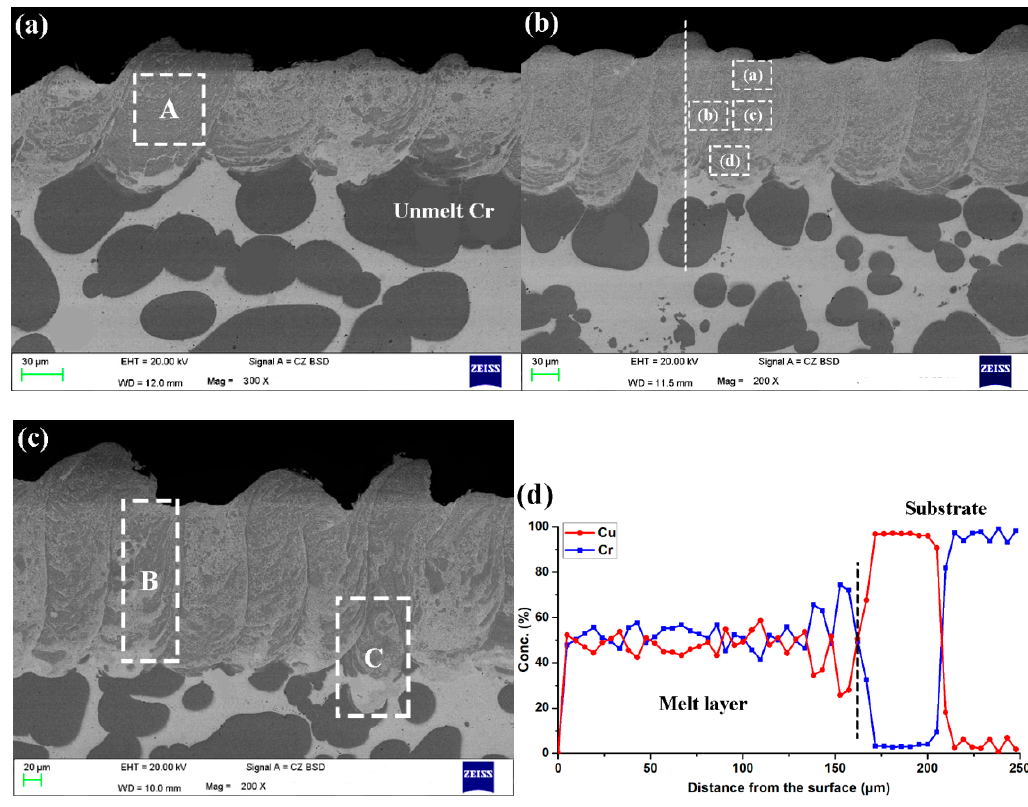
Figure 4. Microstructure of the melt layer under various laser energy densities: ( a ) E = 43.8 MJ/m 2 ; ( b ) E = 52.5 MJ/m 2 ; ( c ) E = 66.3 MJ/m 2 ; and ( d ) EDS line scanning along the black dotted line in Figure 4b.